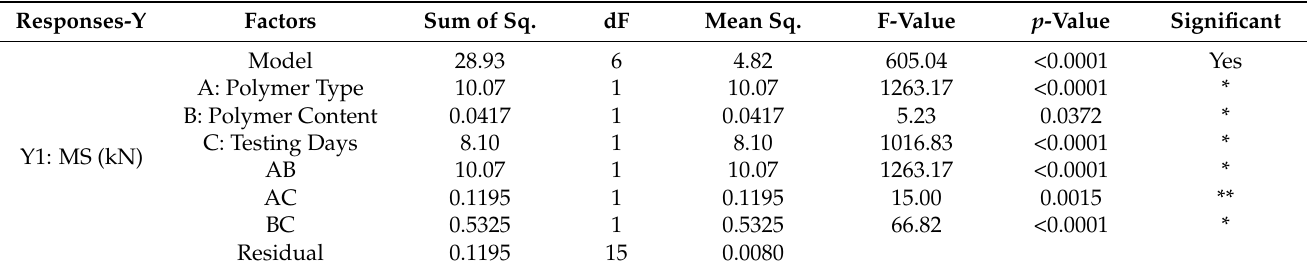
Table 4. ANOVA results for responses and factors of modified asphalt